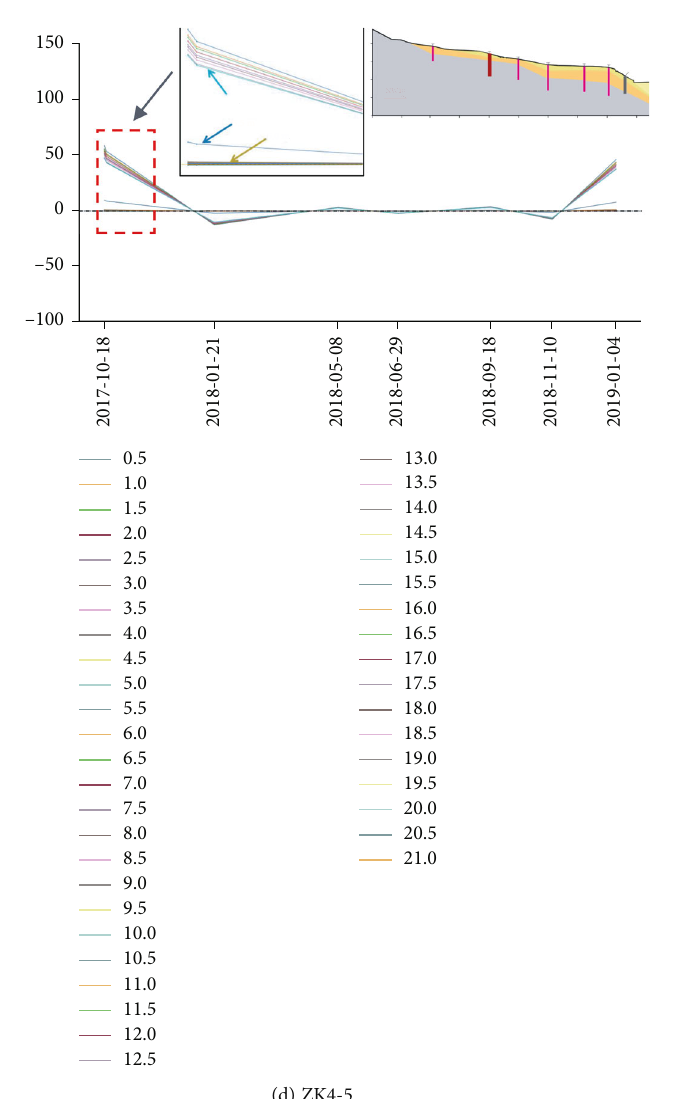
Figure 19: Displacement rate curve cluster at di ff erent depths of ZK4-1, ZK4-2, ZK4-3, and ZK4-5 boreholes (ZK4-1 borehole is 50m deep with an interval of 0.5m; ZK4-2 borehole is 39 m deep with an interval of 0.5 m; ZK4-3 borehole is 34m deep with an interval of 0.5m; and ZK4-5 borehole is 21m deep with an interval of